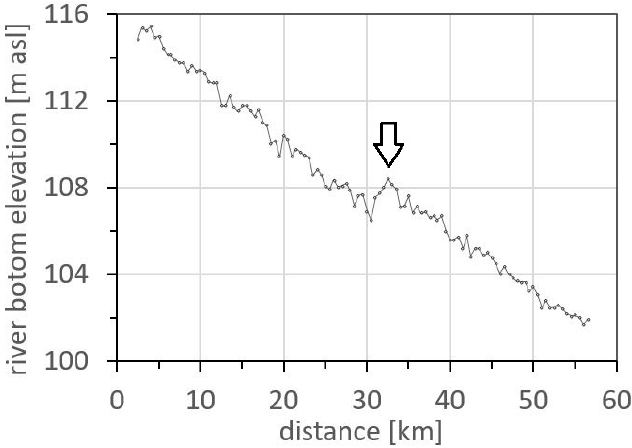
Figure 2. Riverbed elevation of the River Elbe as proxy for the river depth; the arrow indicates a major shallow river section.